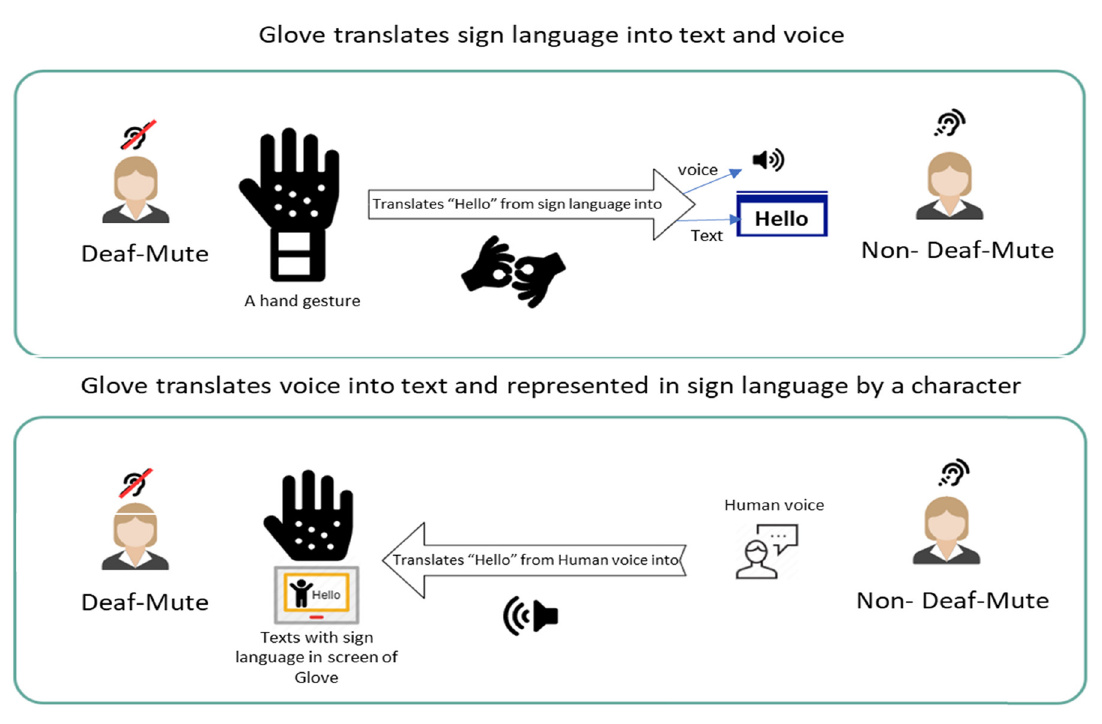
Figure 1: An illustration of the interaction between a deaf - mute and a non - deaf - mute using